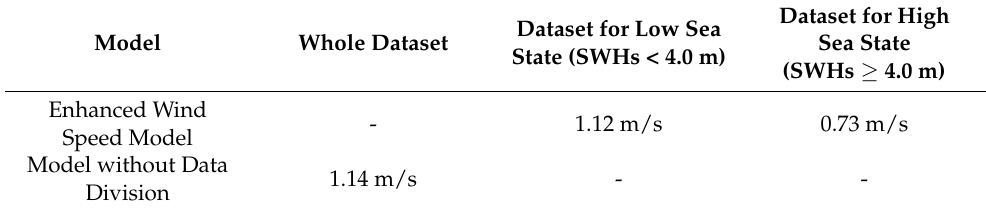
Table 1. RMSE of the retrieved wind speed.